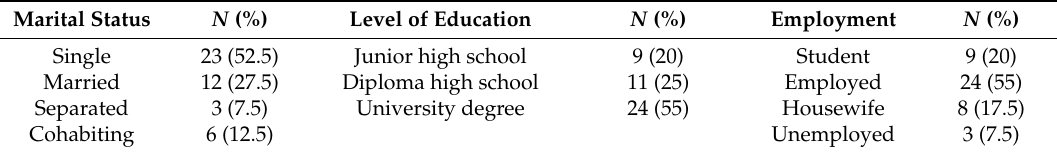
Table 1. General data collection form results of the 44 r-AN patients at the 10-year follow-up.